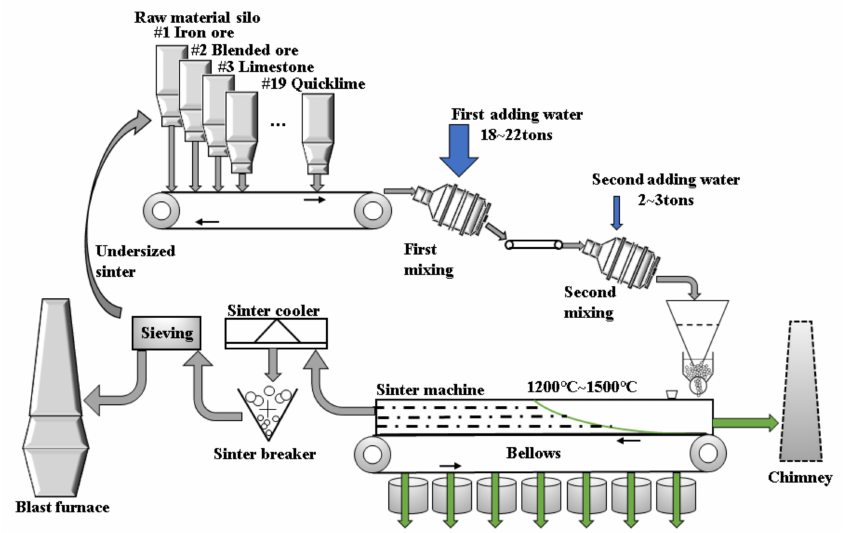
Figure 1. Sintering process layout